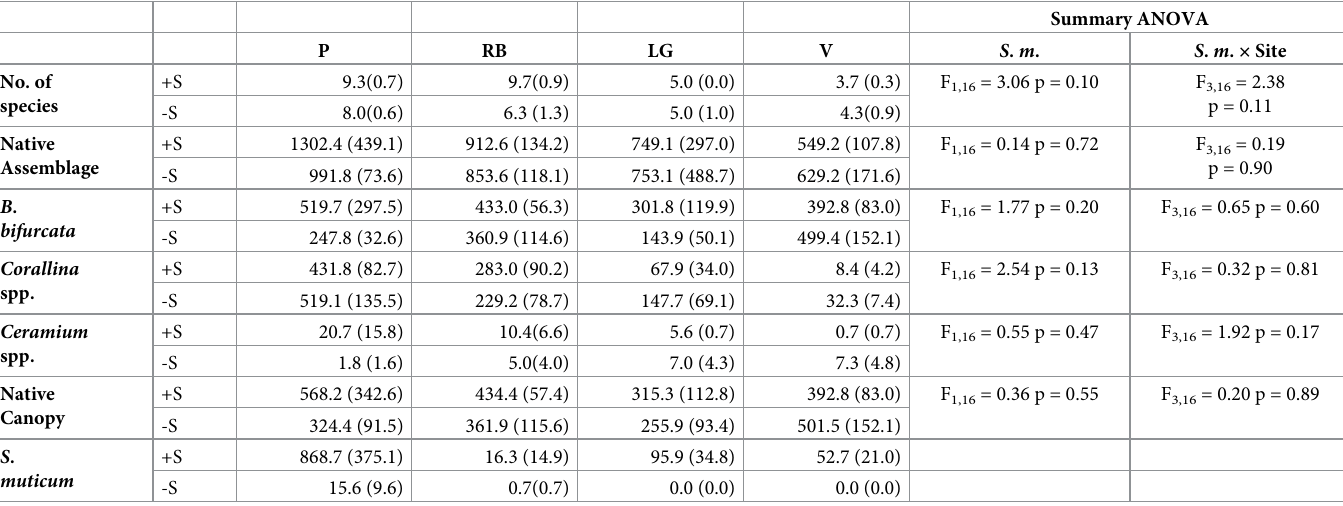
Table 2. Diversity and biomass of the macroalgal assemblages.